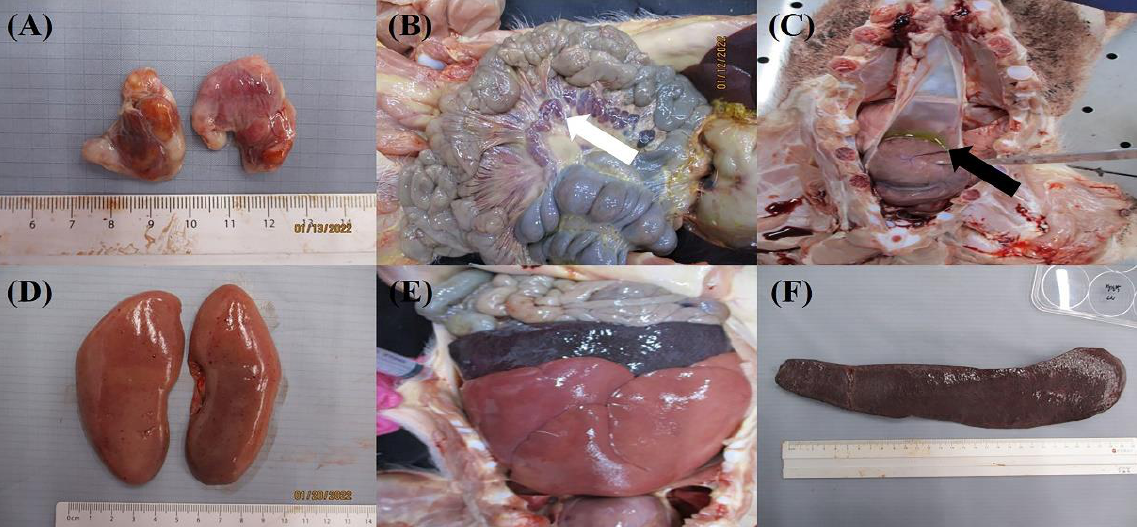
Figure 4. Gross lesions at necropsy. ( A ) Enlargement and hemorrhage of submaxillary lymph nodes in pig no. 1, ( B ) enlargement and hemorrhage of mesenteric lymph nodes in pig no. 3 (white arrow), ( C ) hydropericardium in pig no. 10 (black arrow), ( D ) petechiae in renal cortex in pig no. 4, and ( E ) and (F) thickened and enlarged spleen in pig no. 4.